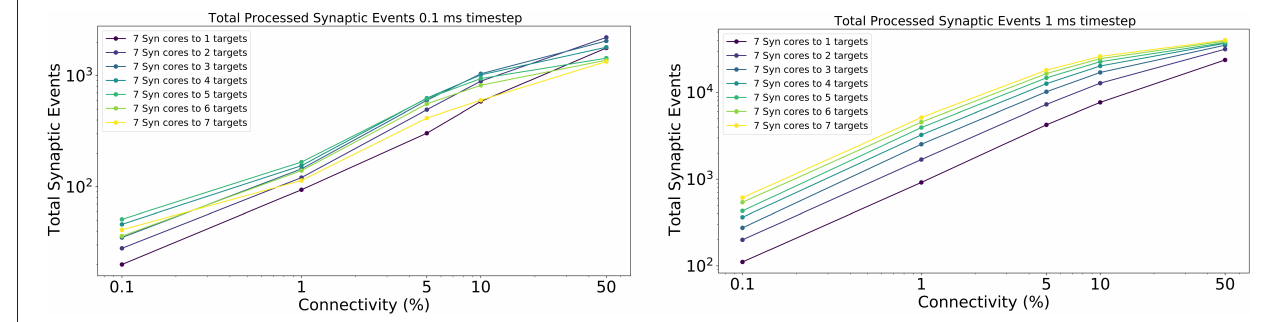
FIGURE 14 | Processed synaptic events for different connectivity configurations. Both the 0.1 ms timestep (left) and 1 ms timestep (right) cases are shown. The vertical axis shows the total processed synaptic events per timestep, the horizontal axis different connectivity probabilities. Each line represents a different neural ensemble with constant Synapse cores, but increasing target Neuron